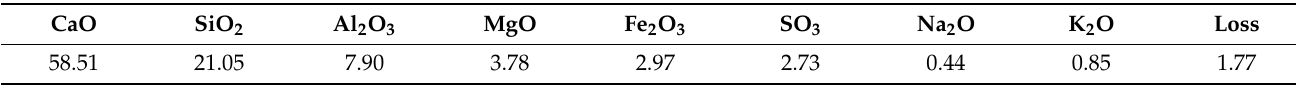
Table 1. Cement chemical components/%.